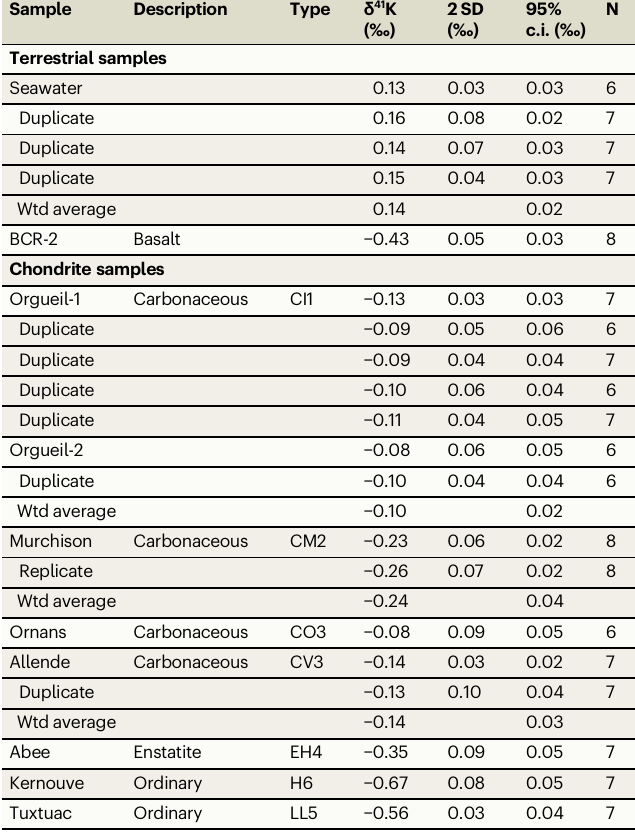
Tables1and2presentthe δ 41 Kvalues( ‰ ),twostandarddeviations(2SD),and95%con fi dence interval(c.i.)forasamplesolutionmeasuredNtimesduringananalyticalsession.The95%c.i.is calculatedfromt×[SD/ √ (N-1)],wheretistheStudent ’ s t numberandSDisthestandarddeviation of δ 41 K valuescalculated forallmeasurements ofbracketing standard(NIST 3141a) during a session. Duplicaterepresents repeat instrumental analysis on thesamepuri fi ed K solution during different sessions. Replicaterepresents repeat column chemistry from the samebulk dissolution. Thelabels ‘ − 1 ’ and ‘ − 2 ’ attachedtothenameofagivensamplerefertoanewdissolution,column chemistry, andinstrumental analysis. Wtd averageistheerror-weighted